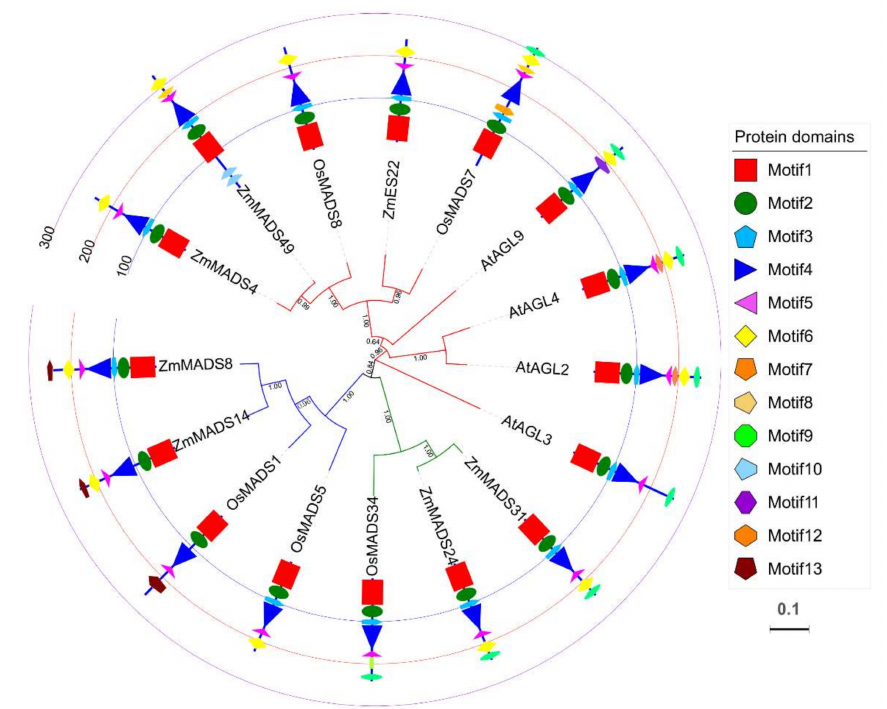
Figure 1. Phylogenetic tree of ZmES22 homologous genes from maize, rice and Arabidopsis. Phylogenic tree of homologous genes of ZmES22 from maize, rice and Arabidopsis MADS proteins, which was constructed using conserved MADS domain with MEGA7 software via Neighbor-joining method. Bootstrap value was indicated at each branch point. Gene IDs and predicted functions are listed in Supplementary Table